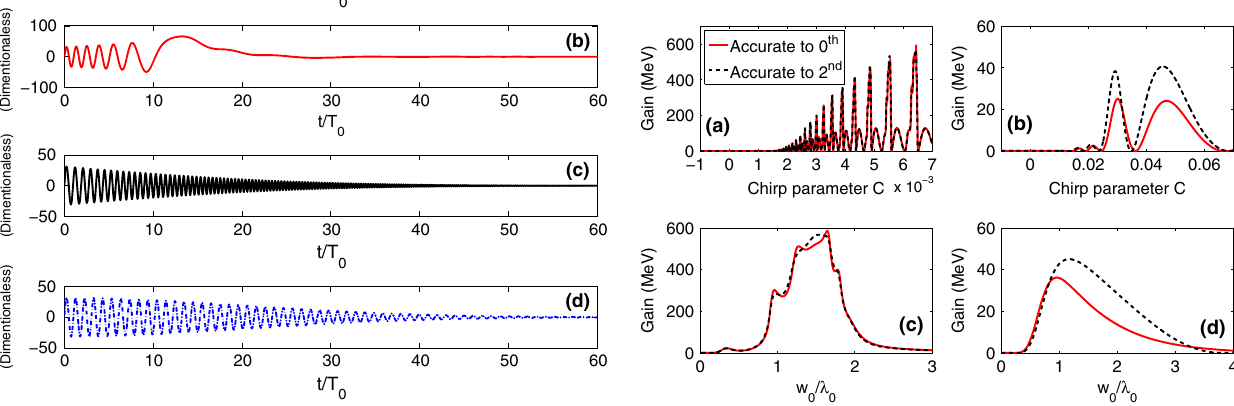
FIG. 5. Energy gain of a test single proton as a function of the ¼ 20 T ¼ (a) and t chirp parameter C for the pulse duration t 0 0 0 (b). The energy gain of a test proton as a function of the laser 2 T 0 ¼ 20 T is plotted in (c) and (d) for t ( C ¼ beam waist w 0 0 0 ¼ 2 T ( C ¼ 0 : 046 ), respectively. The red line 0 : 006 42 ) and t 0 0 and the black line represent results obtained by adopting laser field accurate to 0th order and 2nd order, respectively. Other parameters are the same as in Fig.